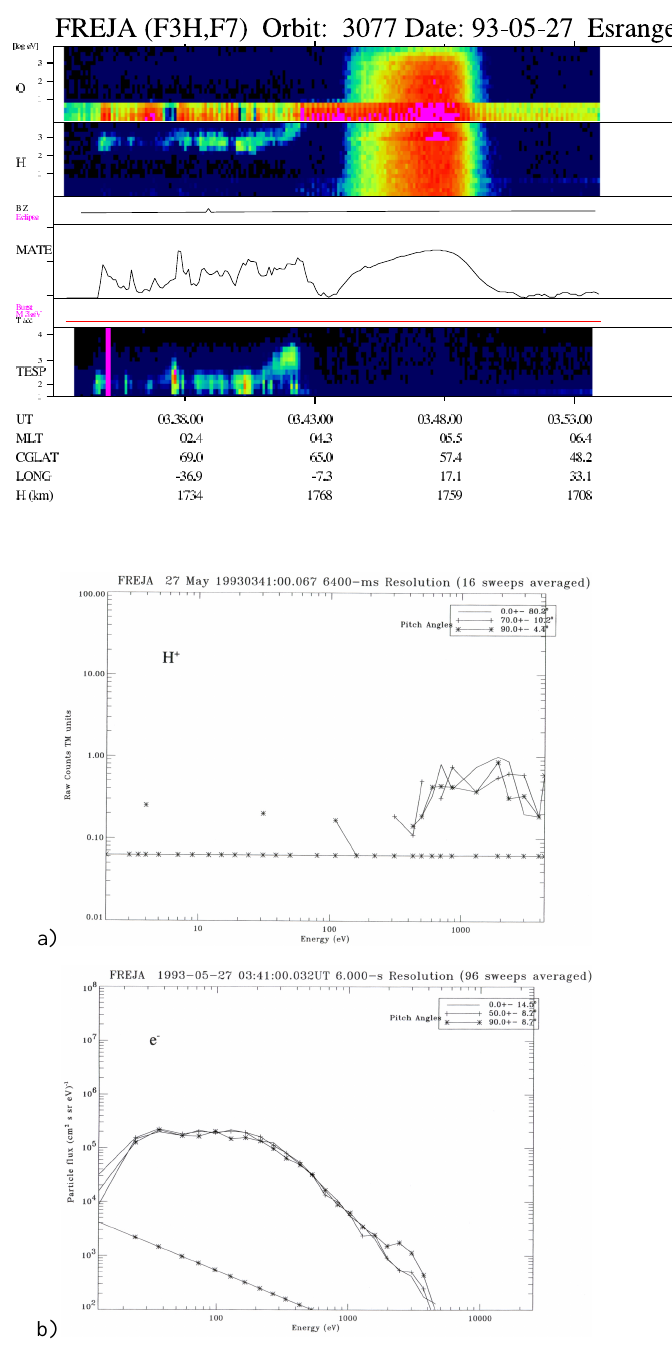
Fig.20. Measured energy spectra of H + ions (count rate) (a) and energetic electrons (differential particle flux) (b) when the ion ener- gies reached the upper energy limit of the spectrometer in Fig.18. Straight lines show 1-count